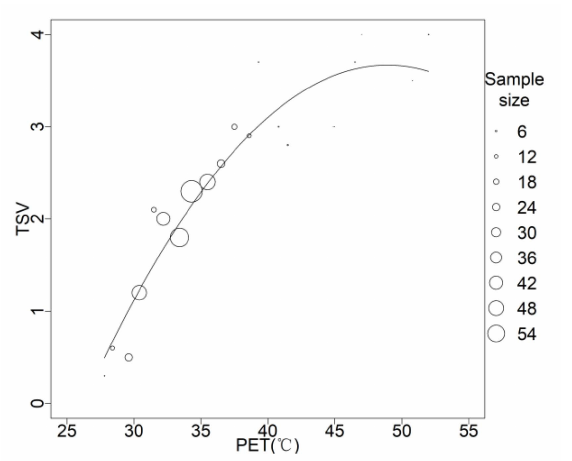
Figure 7. Correlation between PET and mean